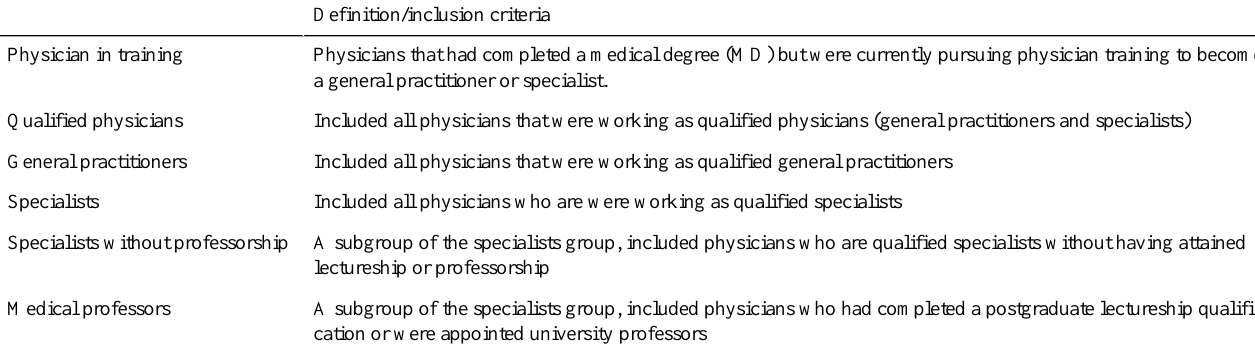
Table 1. Subgroups of